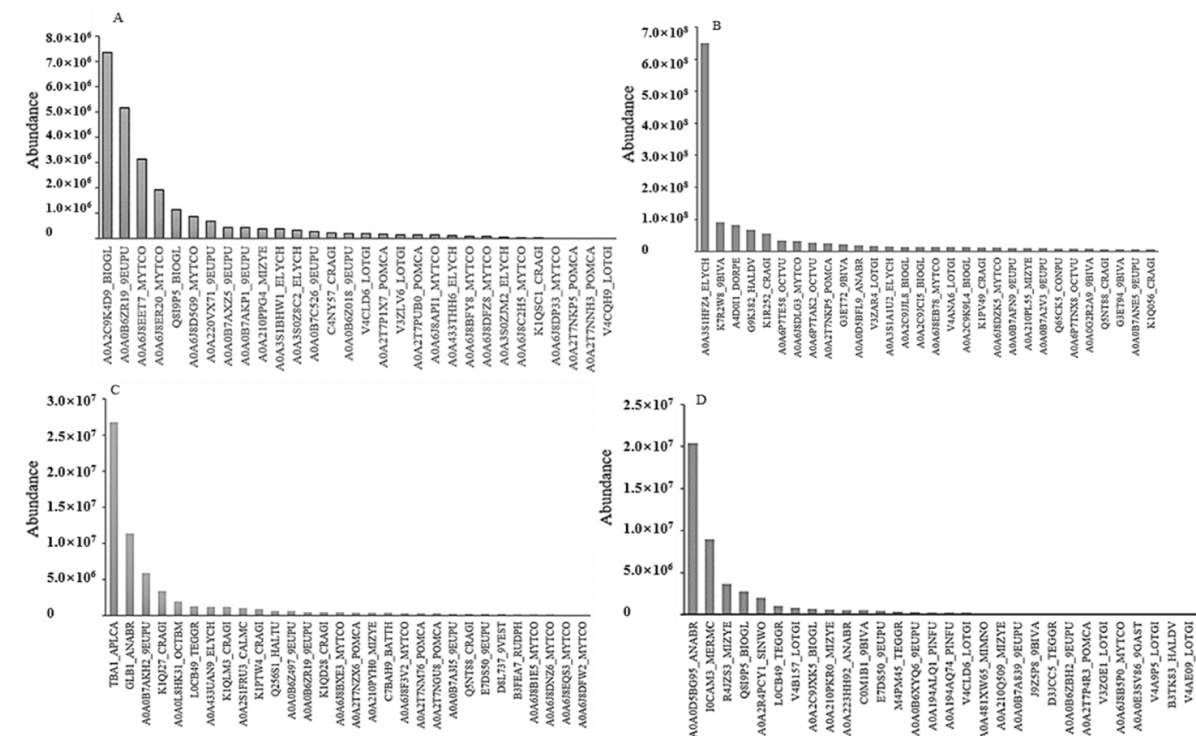
Figure 3. Top 30 most abundant prey proteins for bait ORF72 by MS/MS analysis. Subfigures ( A – D ) correspond to the results for the proteins identified in bands a, b, c and d.